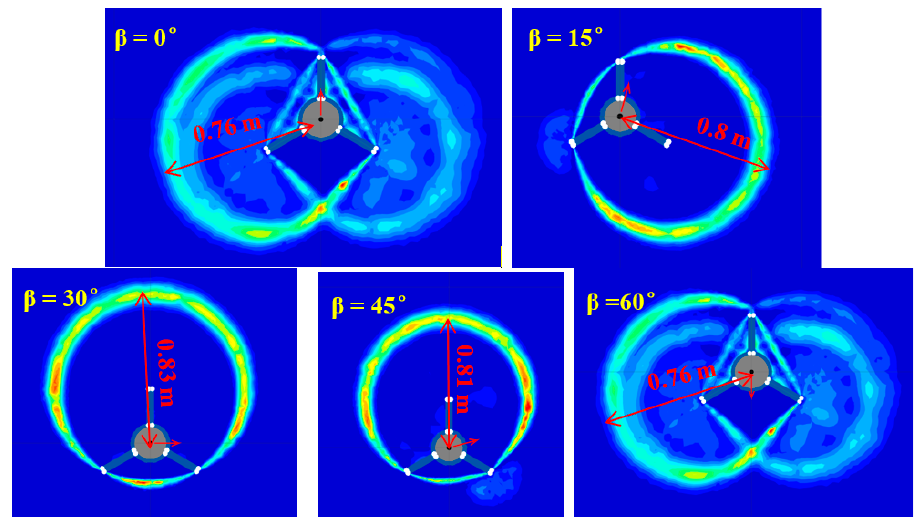
Figure 10. Effect of different lateral-load directions on the shear plastic zone of the soil around the three-wing pile when pile–soil interaction coefficient a = 0.4 and D e /B w = 2.5. ( D e : effective diameter; B w : wing width.).